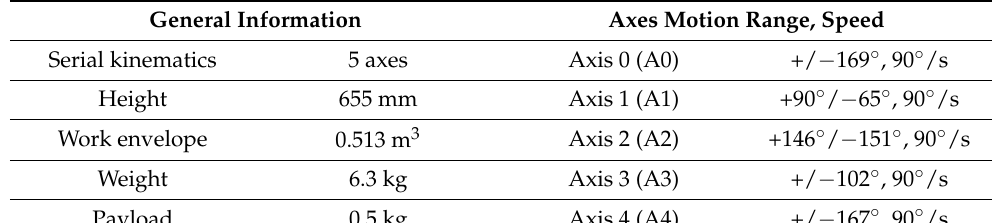
Table 2. General characteristics KUKA-YoubBot arm [39].